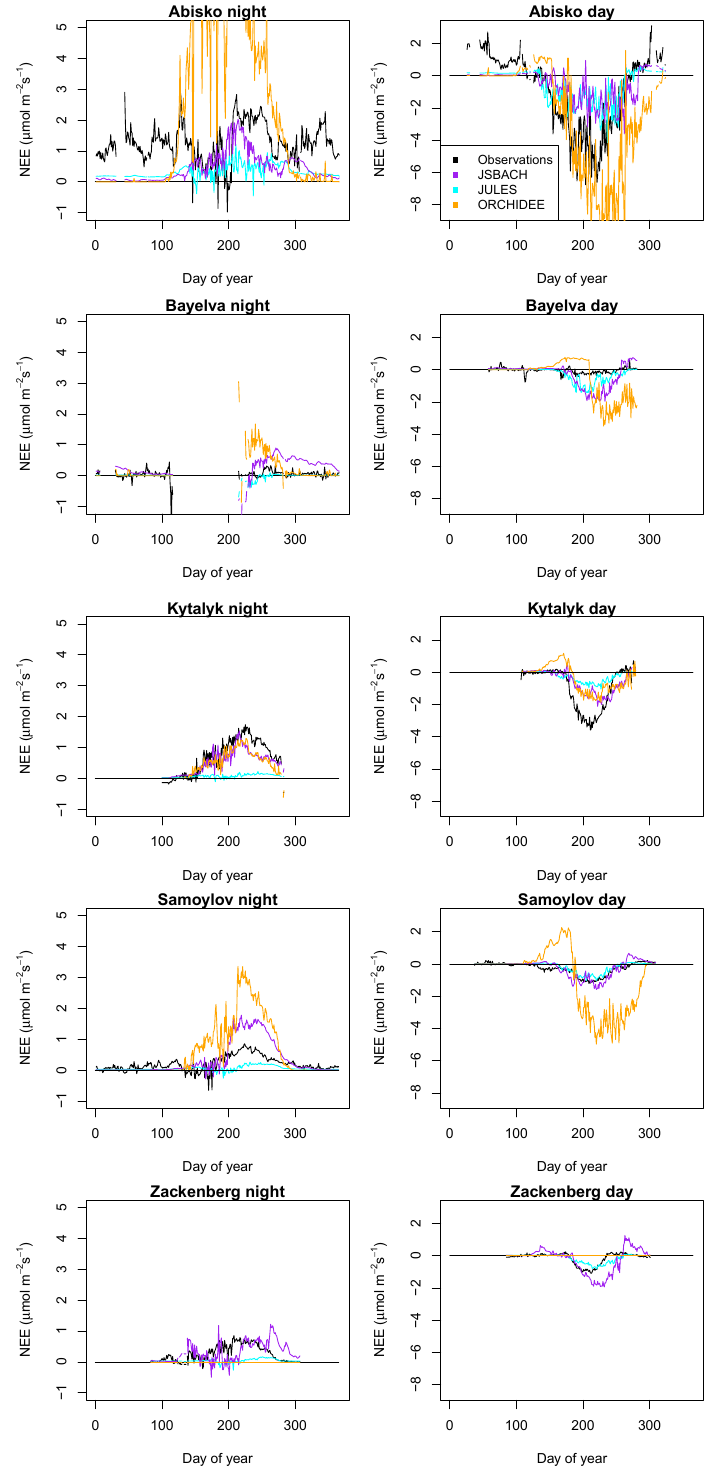
Figure 7. Mean annual cycles of CO 2 fluxes for all sites, observations and models. Left: night-time flux; right: daytime flux (corresponding to incoming shortwave radiation > 20Wm − 2 ). See Table S1 for the years used at each